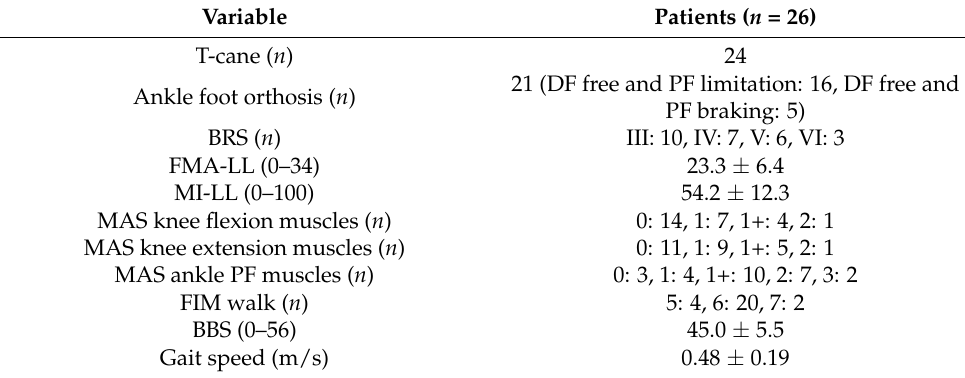
Table 1. Cont. Variable Patients ( n =